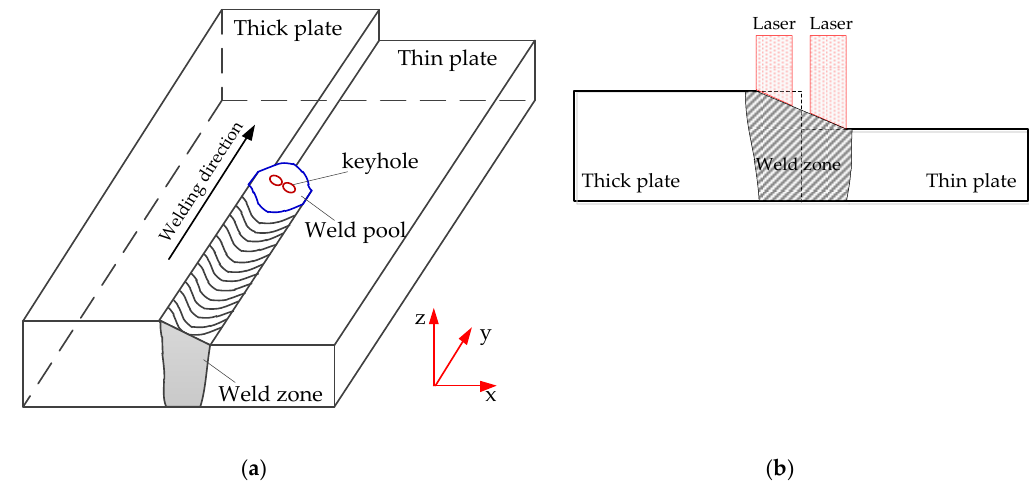
Figure 2. Dual-beam laser welding of tailored blanks with different thicknesses: ( a ) Schematic diagram; ( b ) cross-section of tailored blanks welded